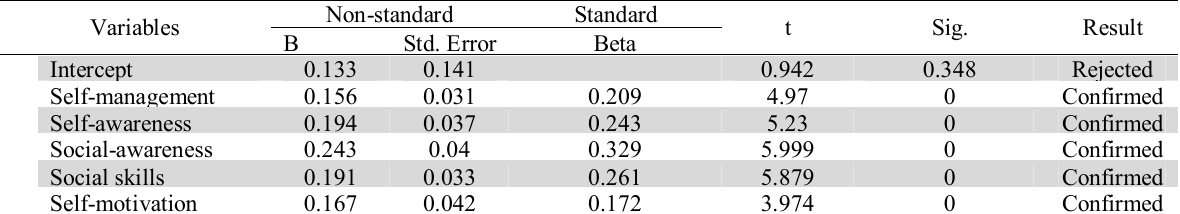
The summary of regression model